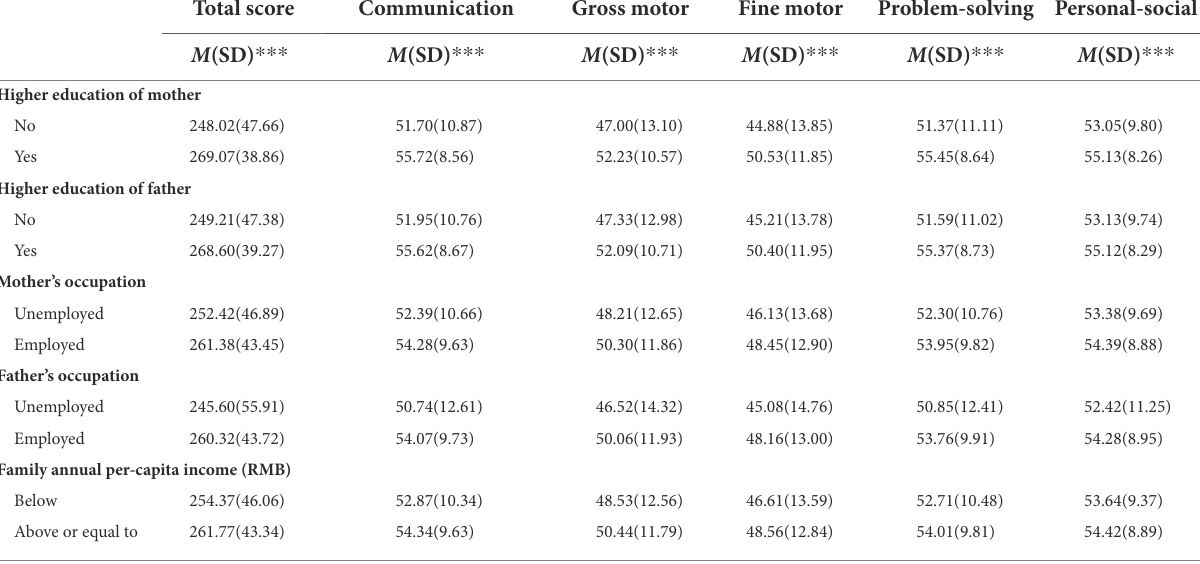
TABLE 2 The mean scores of ASQ-3 in children with different socioeconomic characteristics ( N = 115,915).